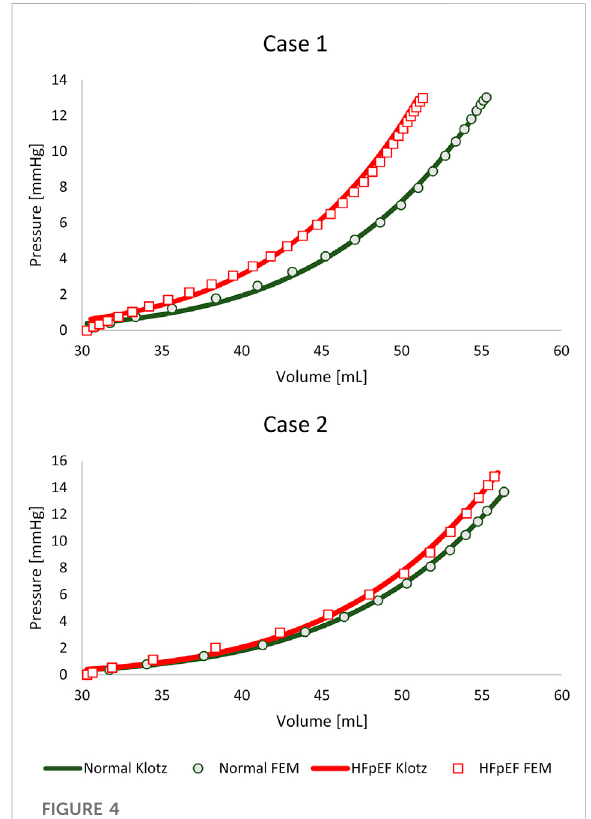
FIGURE 4 The passive fi lling FE results and the corresponding “ Klotz ” curves for the four models.